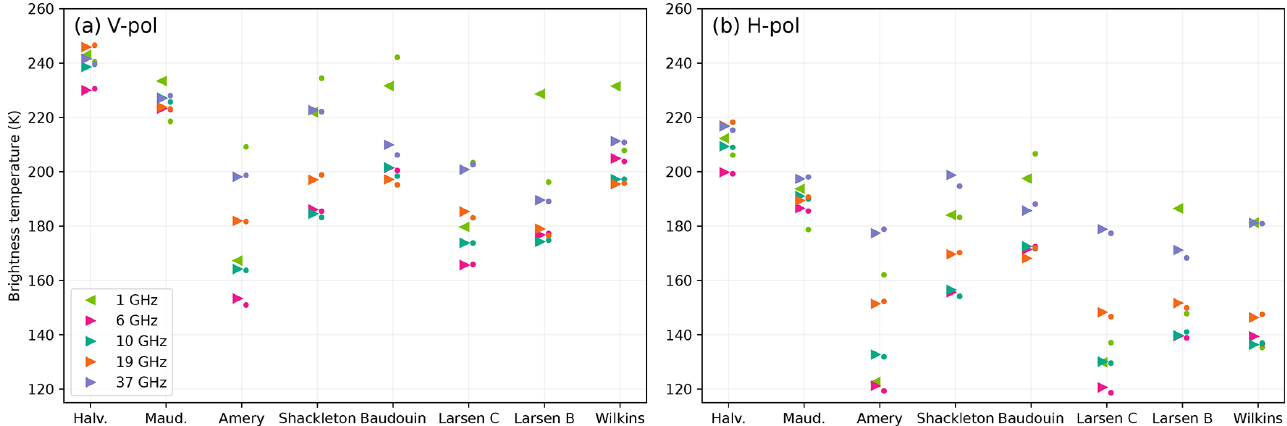
Figure 3. Observed (triangles) and modeled (dots) June–September brightness temperatures at vertical polarization (a) and horizontal polar- ization (b) for SMOS and AMSR2 frequencies. The sites are sorted by increasing number of melt